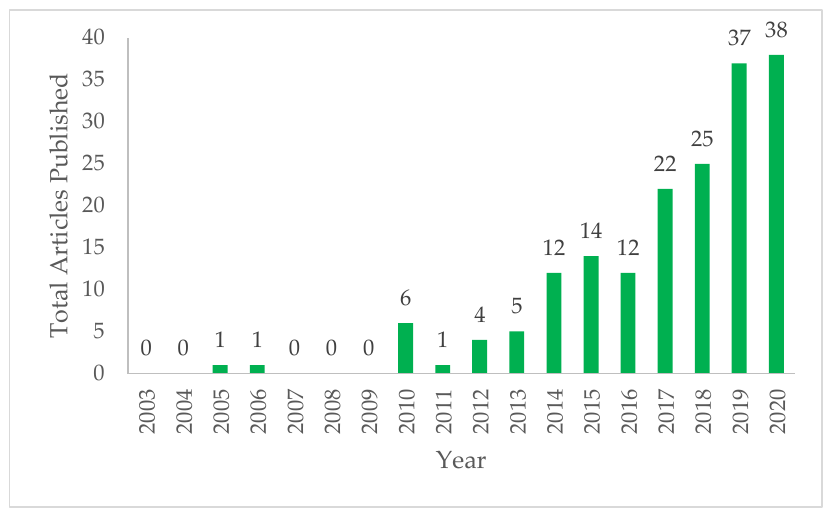
Figure A1. Publications indexed in Europe PMC between 2003 –2020 that reference “green exercise” [8], i.e., physical activity performed while exposed to nature.